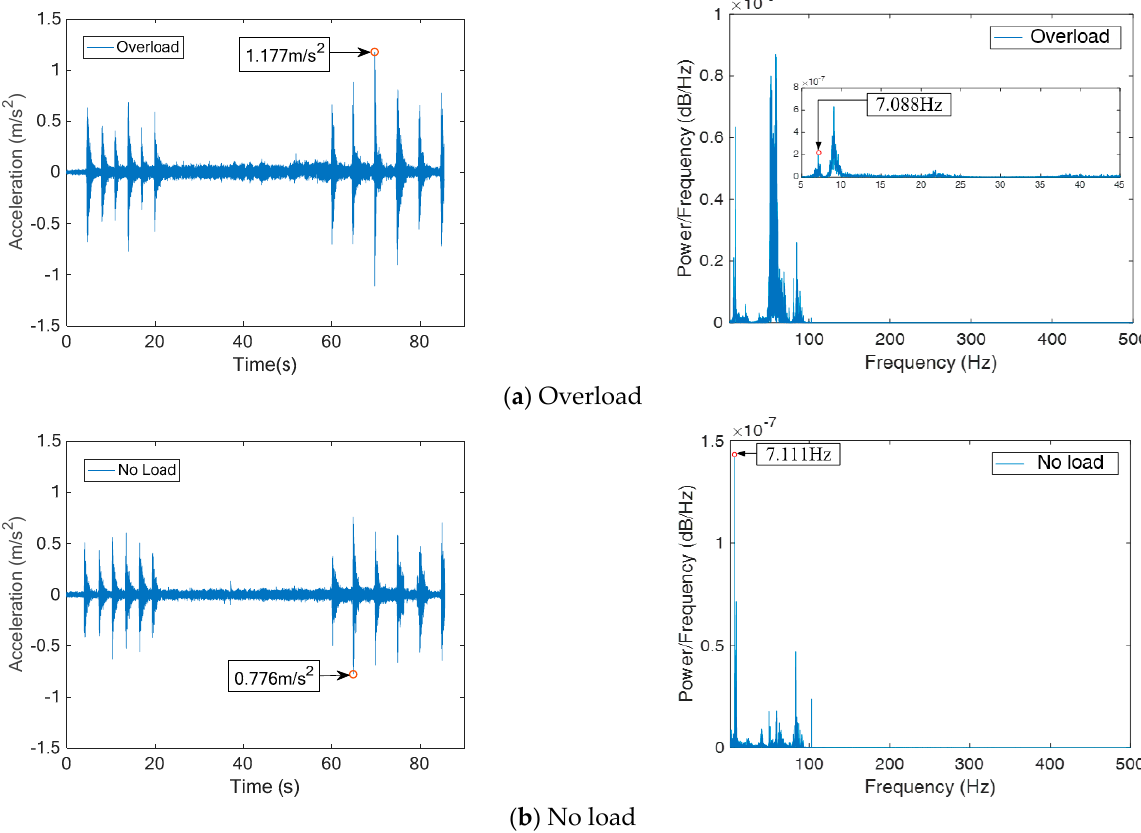
Figure 10. Effect of vehicle load on the vertical acceleration of the bridge.